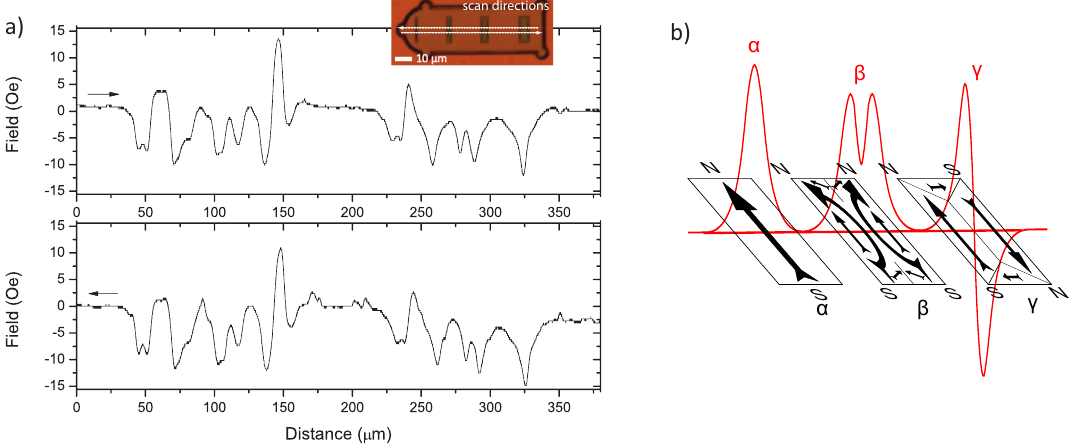
Figure 6. ( a ) Two four-bit tags are scanned in the forward (above) and the reverse (below) directions, showing a high level of reproducibility. The sensitive axis of the TMR sensor points along the length of the magnetic elements. A 10 µ m/s scan speed was used with a measurement time-constant of 100 ms. The vertical distance between the sample and sensor is ≈ 1 µ m. It is evident from the stray fields observed that the magnetic elements are not uniformly magnetised, but instead must exhibit ferromagnetic domain structures; ( b ) Schematic of three characteristic signal shapes, labelled α , β and γ . The corresponding distribution of edge north (N) and south (S) poles are shown along with the possible domain distributions from which these could